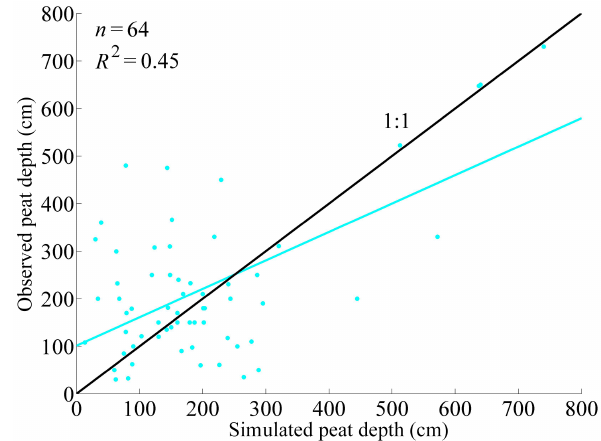
depths in Alaska: the observed and simulated data are extracted from the same grids on the map. The linear regression line (cyan) is compared with the 1:1 line. The linear regression is signifi- cant ( P < 0 . 001, n = 64) with R 2 = 0 . 45, slope = 0.65, and inter- cept = 101.05cm. The observations of > 1000cm are treated as out-